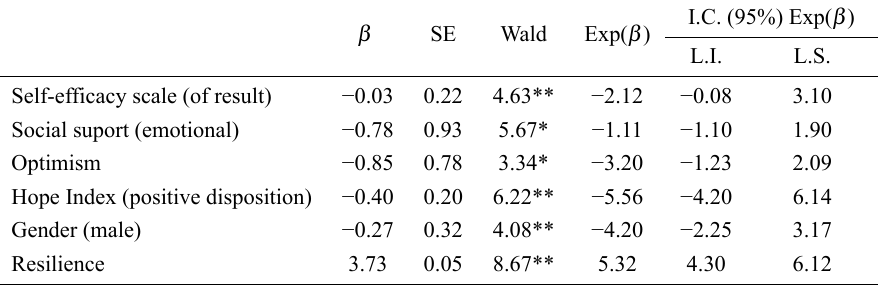
Table 1. Regression equation values for predicting suicide lethality by protective